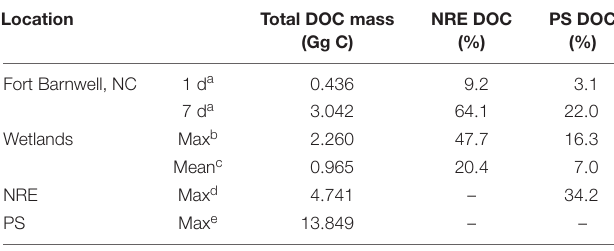
TABLE 2 | DOC mass loading from Neuse River and freshwater wetlands into the NRE-PS, during hydrologic connectivity, in response to Hurricane Matthew. Location Total DOC mass